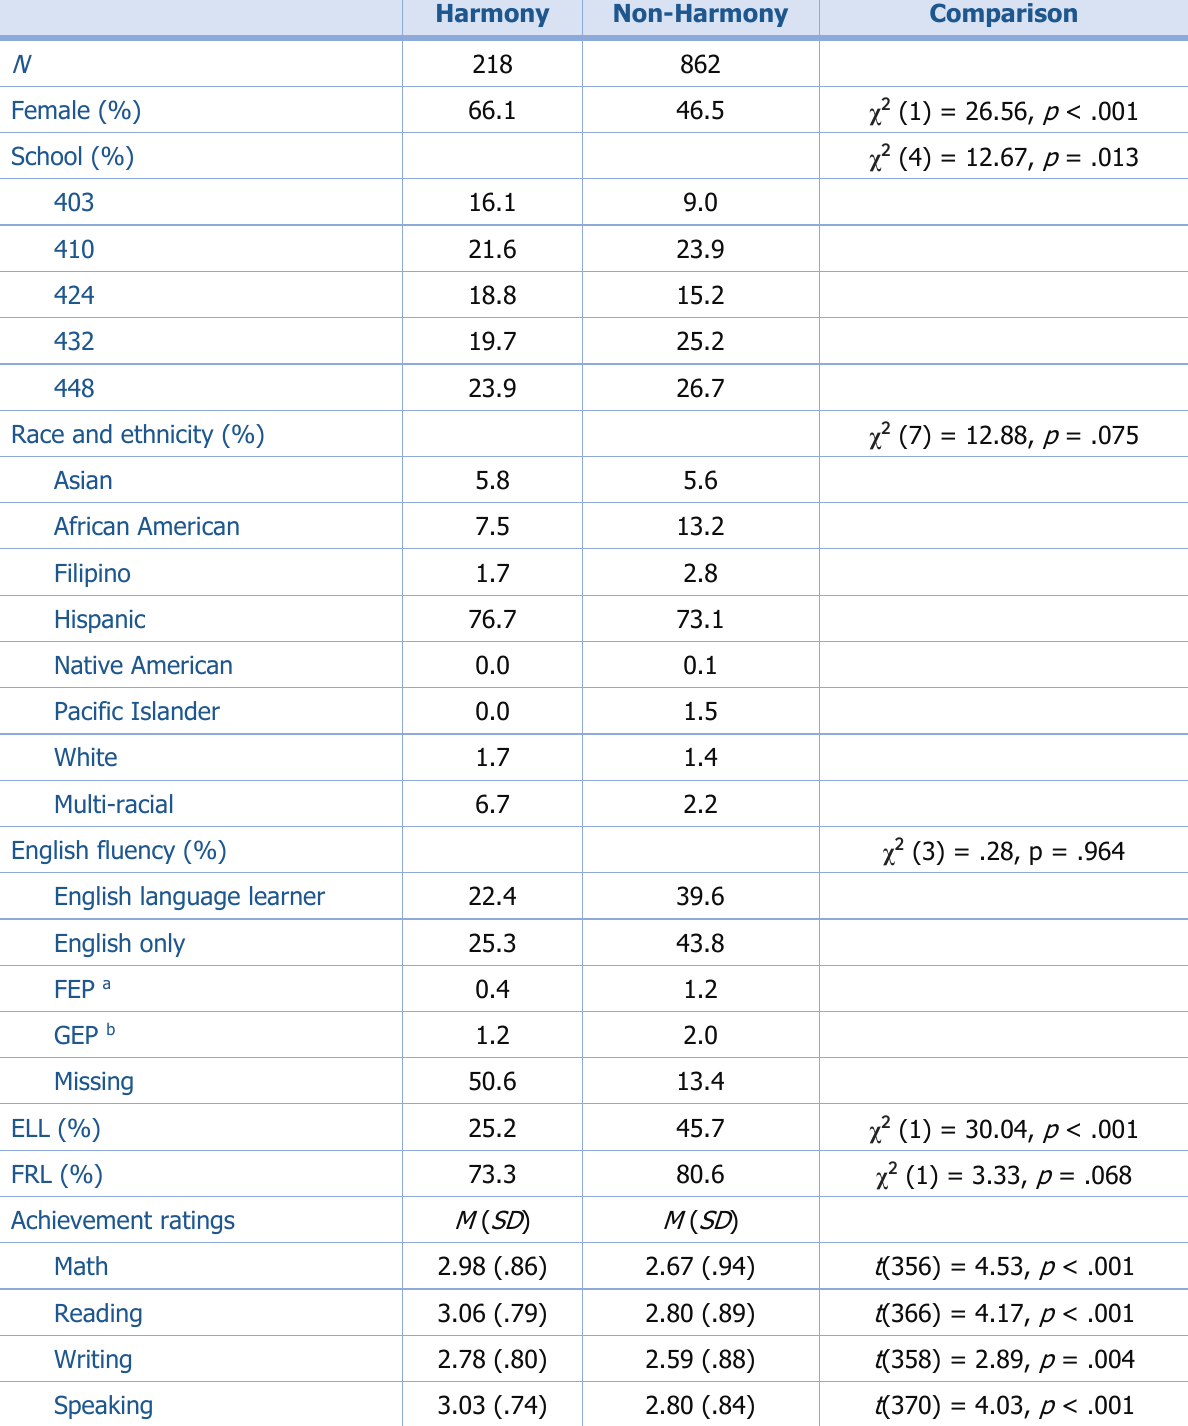
Table 2. Demographic and Academic Characteristics of Harmony and Non-Harmony Students for 1-Year